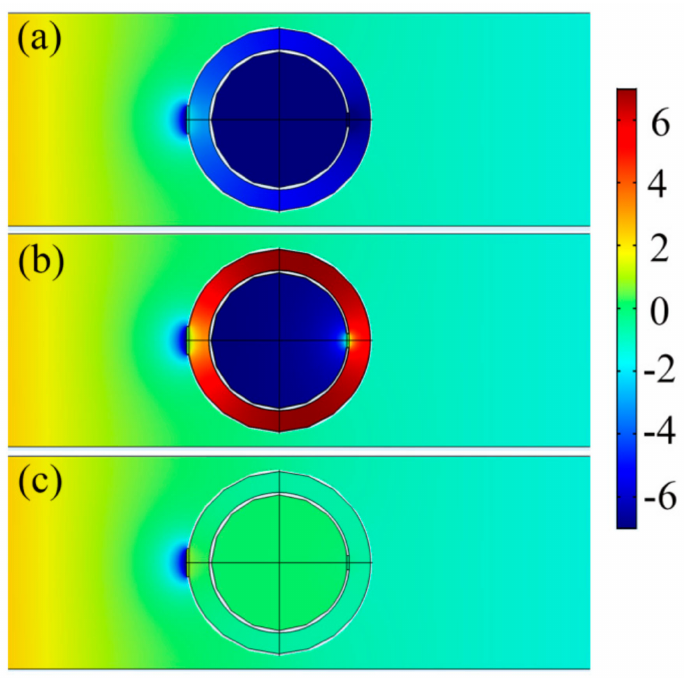
Figure 4. The acoustic pressure field distribution of the NSHS-AMM. ( a ) 504 Hz; ( b ) 1172 Hz; ( c ) 1900